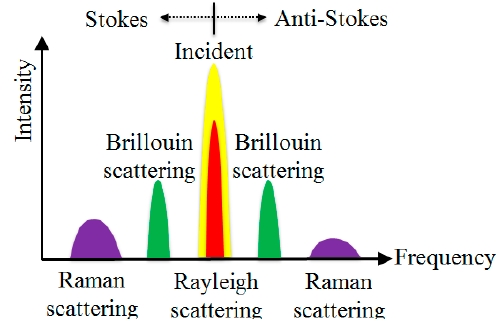
Figure 10. Light scatterings in optical fiber.